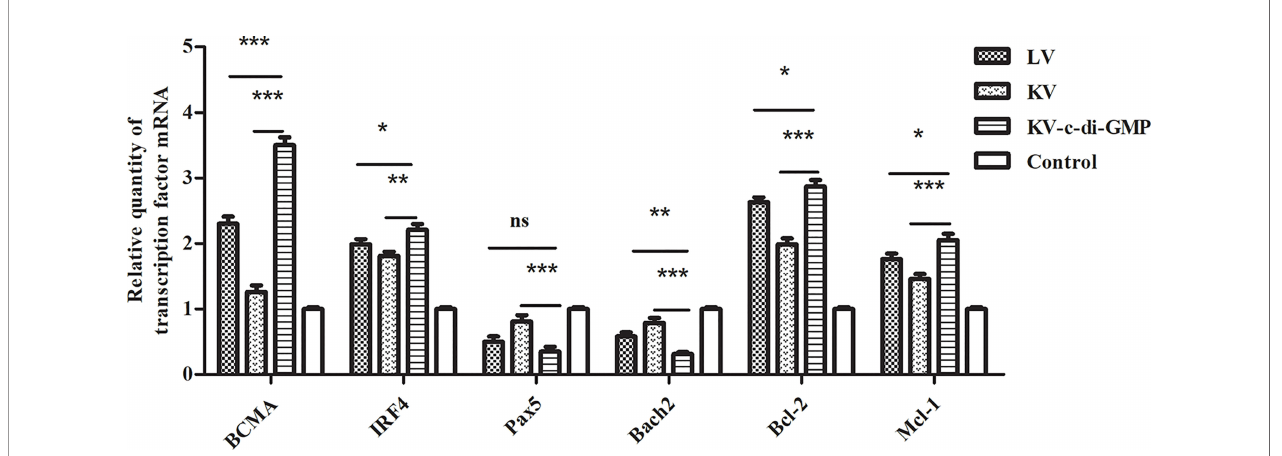
FIGURE 6 | Real-time RT-PCR showing the relative expression of transcription factor genes in lymphocytes from LNs at 28 dpi. The relative gene expression was calculated by 2 - DD Ct. DD Ct = (Ct [target gene] -Ct [reference gene]) experimental group - (Ct [target gene] -Ct [reference gene]) control group . Data are expressed as mean ± standard deviation from three mice/group and represent three independent experiments. Pooled LNs from three mice were processed independently three times. * P < 0.05; ** P < 0.01; *** P < 0.001; ns, no signi fi cant